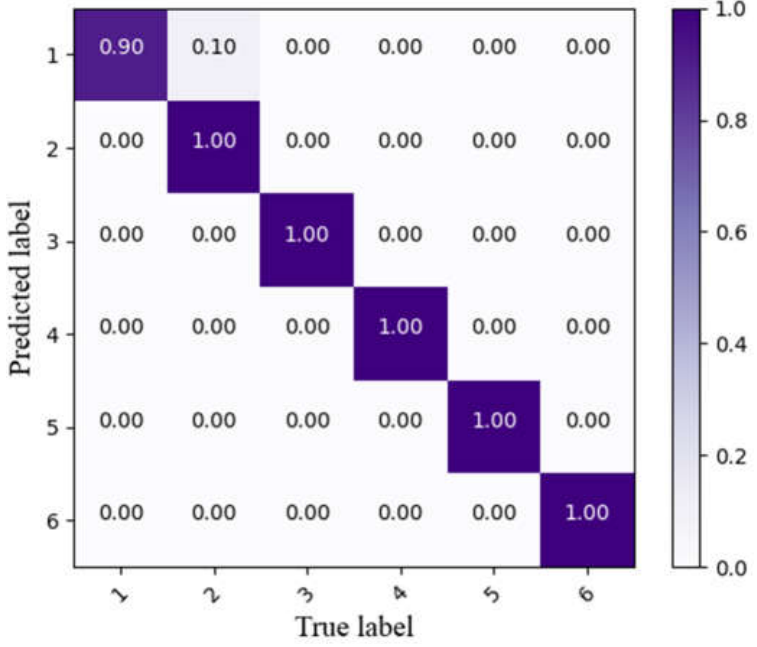
Figure 8. Confusion matrix of the first trial of the proposed method.